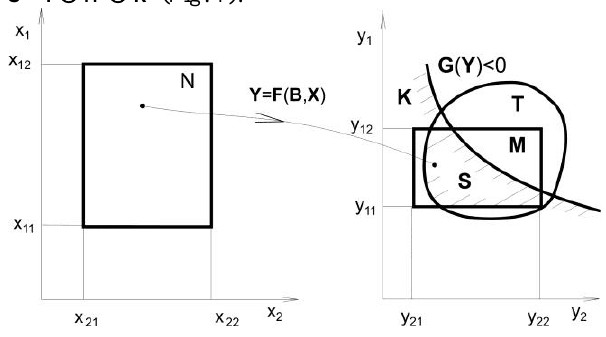
Fig. 1. Determination of the region S of admissible values of output parameters